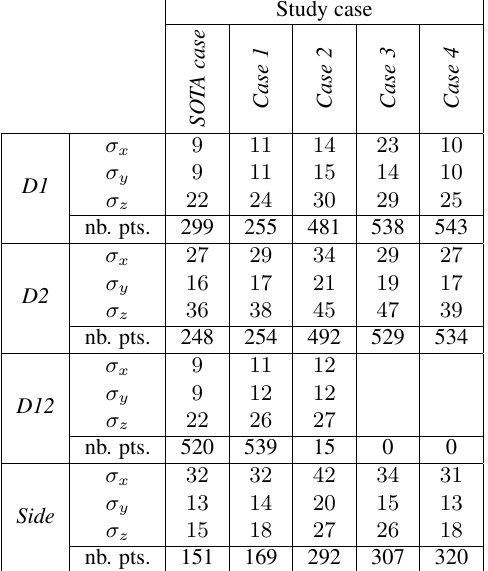
Side Table 2: Accuracy prediction of the tie-points representing the canyon floor, and the canyon slopes (unit: mm) equipped with INS/GNSS navigation system and one or multi- ple cameras. This approach can not work due to the degraded GNSS constellation. Nevertheless, we can pretend that high